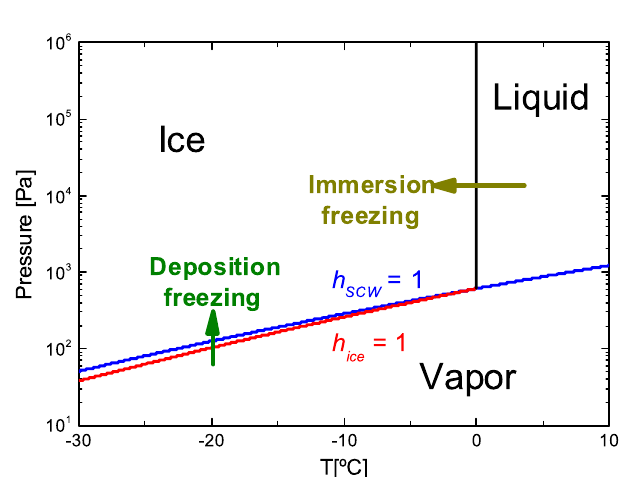
Figure 1. Ice crystallization mechanisms. ( a ) Homogeneous ice nucleation. ( b ) and ( c ) Heterogeneous ice nucleation; ( b ) shows immersion freezing nucleation and ( c ) deposition nucleation. Created with Blender 3.0 (www. blend er. org/).